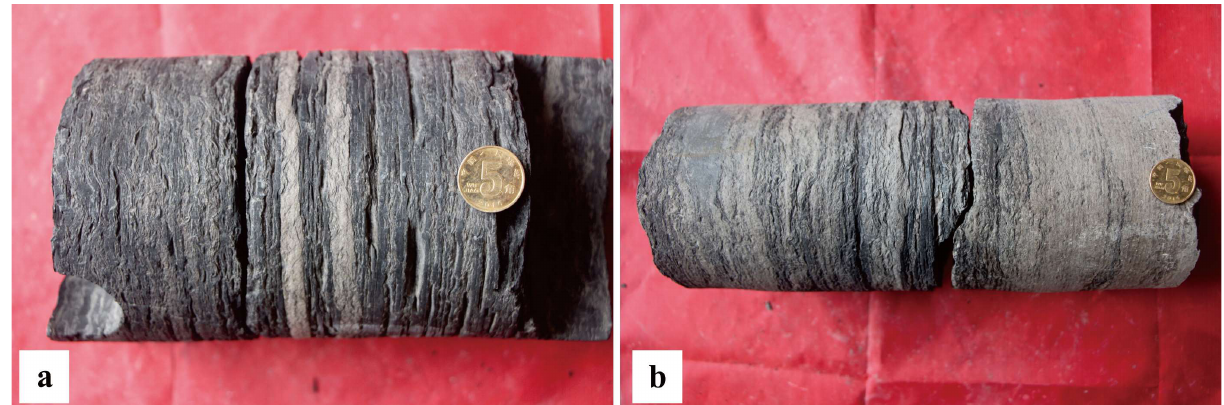
Figure 10. Coring photos with bedding fractures and dissolution fractures: ( a ) Shell mudstone has developed intermediate shell and rich bedding fractures. ( b ) Shell limestone–mudstone interbedding with developed dissolution fractures and bedding joints.